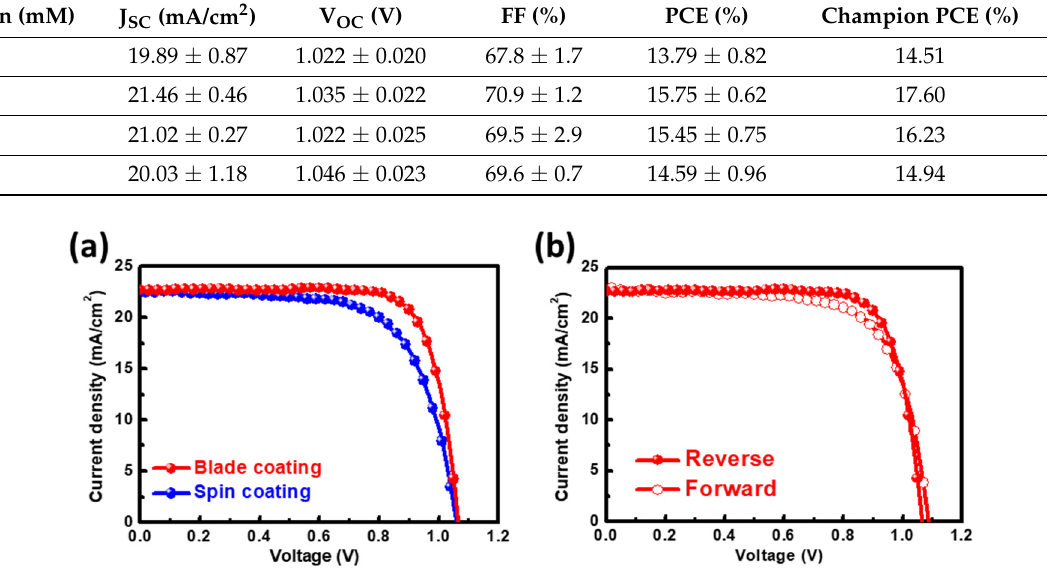
Figure 5. ( a ) J-V curves of the 1.0 mM Tween 20 PSCs prepared by the two different methods. ( b ) Hysteresis measurement of 1.0 mM Tween 20 PSCs prepared by the thermal-assisted blade-coating method.